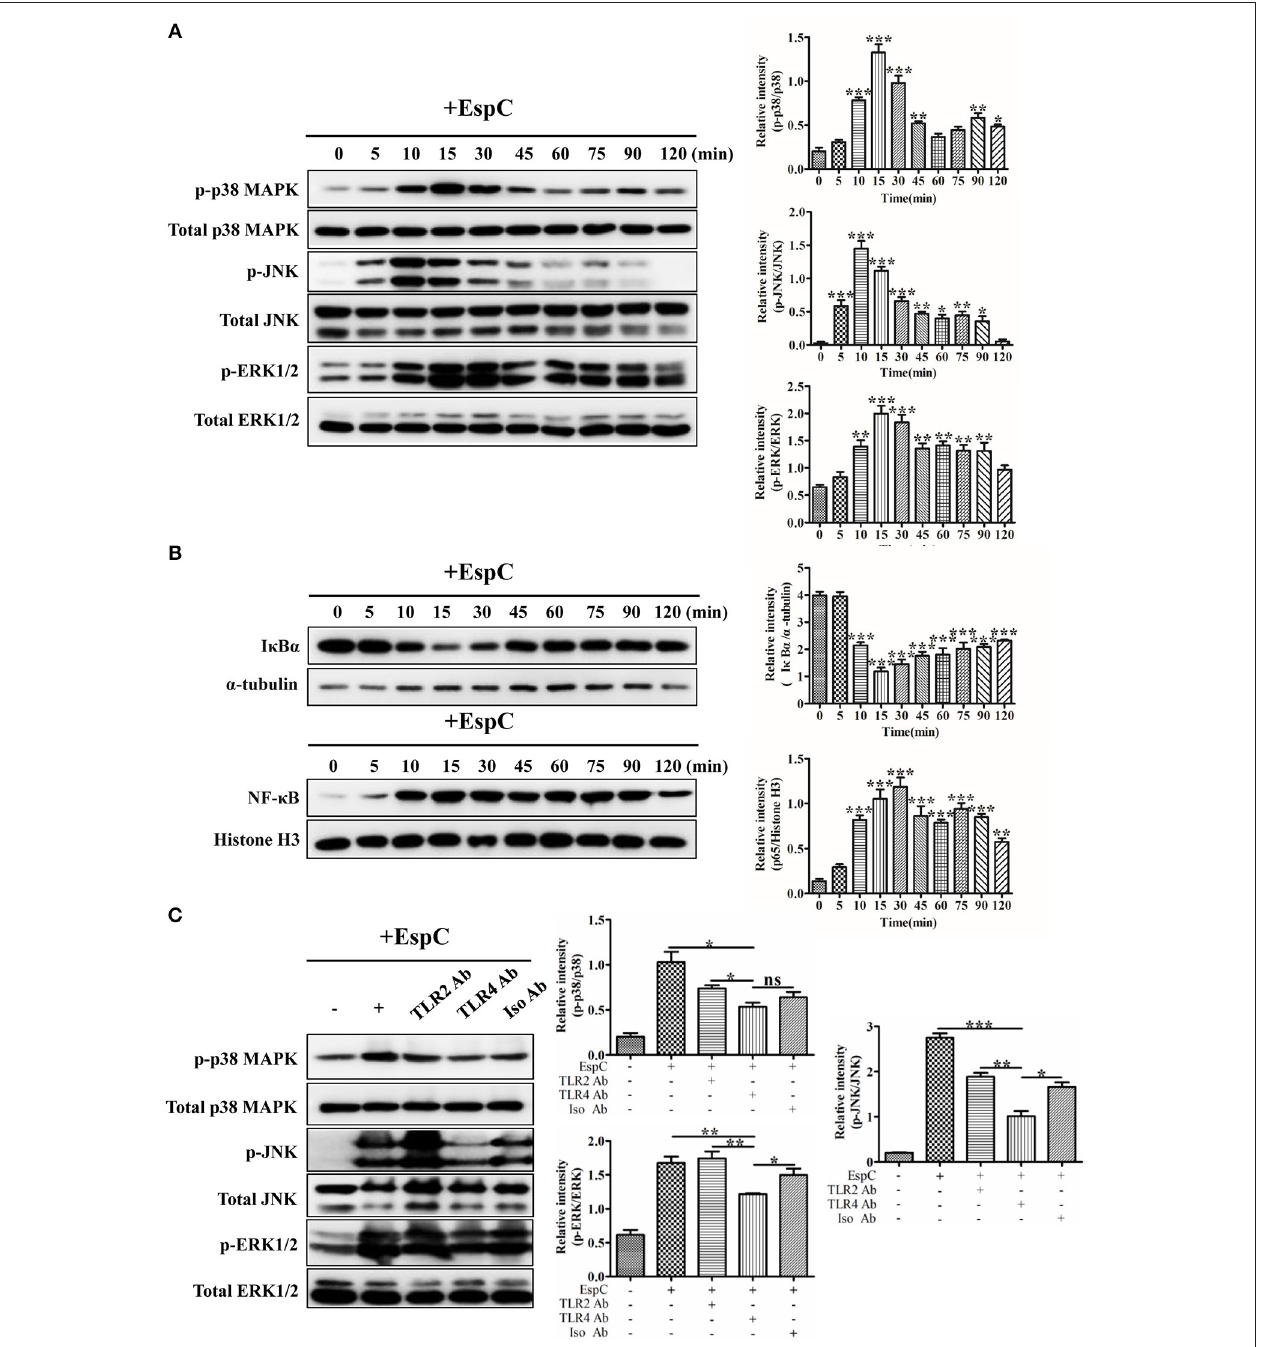
FIGURE 4 | EspC induced the activation of MAPK and NF- κ B. (A) RAW264.7 cells were incubated with EspC (5 µ g/mL) for the indicated times (0, 5, 10, 15, 30, 45, 60, 75, 90, and 120min). Cell lysates were then prepared, and the phosphorylation and activation of p38 MAPK, JNK, and ERK1/2 were examined by western blotting using specific antibodies targeting phospho-p38 MAPK (p-p38 MAPK), p38 MAPK, phospho-JNK (p-JNK), JNK, phospho-ERK1/2 (p-ERK1/2), and ERK1/2. (B) After incubation with EspC (5 µ g/mL) for the indicated times, RAW264.7 cells were subjected to a protocol to separate cytoplasmic and nuclear fractions. The effects of EspC on the translocation of NF- κ B from the cytoplasm to the nucleus and total I κ B α levels in cytoplasmic extracts were determined by western blot analysis. (C) RAW264.7 cells were pretreated with blocking antibodies before stimulation with EspC (5 µ g/mL). Western blotting analysis was performed to analyze the levels of p-p38 MAPK, p-JNK, p-ERK1/2, p38 MAPK, JNK, and ERK1/2. The relative band intensity of each protein was analyzed by Image J. Data are representative of three independent experiments and are shown as means ± SEMs ( n = 3); * p < 0.05, ** p < 0.01, *** p < 0.001.